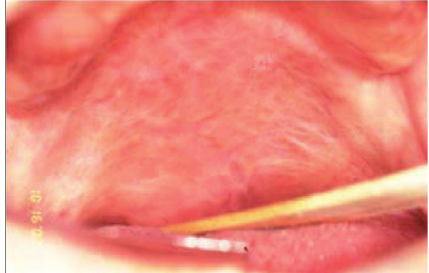
Figure 8: Clinical appearance after treatment with